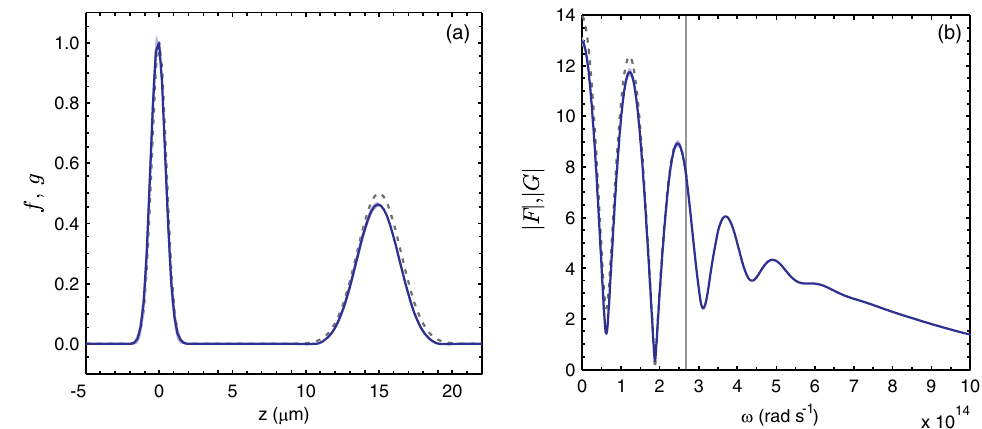
FIG. 5. Reconstruction of a synthetic bunch profile comprising two Gaussians. The initial profile is shown as dashed gray lines in (a). The mean of ten reconstructed profiles is shown as a blue line, and light blue shading represents three- (cid:7) deviation from the mean. The rms lengths of the two Gaussians are 0 : 5 (cid:6) m and 1 : 5 (cid:6) m for the larger and smaller one, respectively, and the separation is 15 (cid:6) m . The spectral amplitudes corresponding to the original and reconstructed profiles are shown in